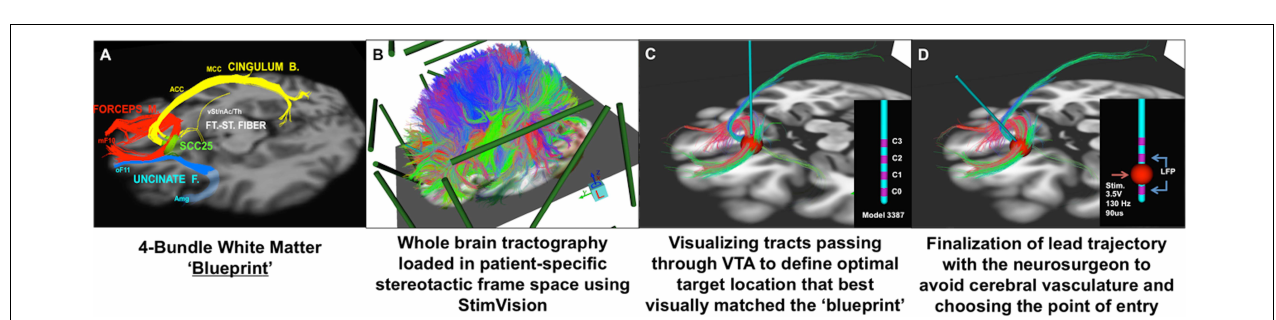
FIGURE 2 | Personalization in Targeting. Closed-loop DBS model for depression, patient selection, and personalized clinical mapping integrating clinical responses, functional and structural connectivity mapping.